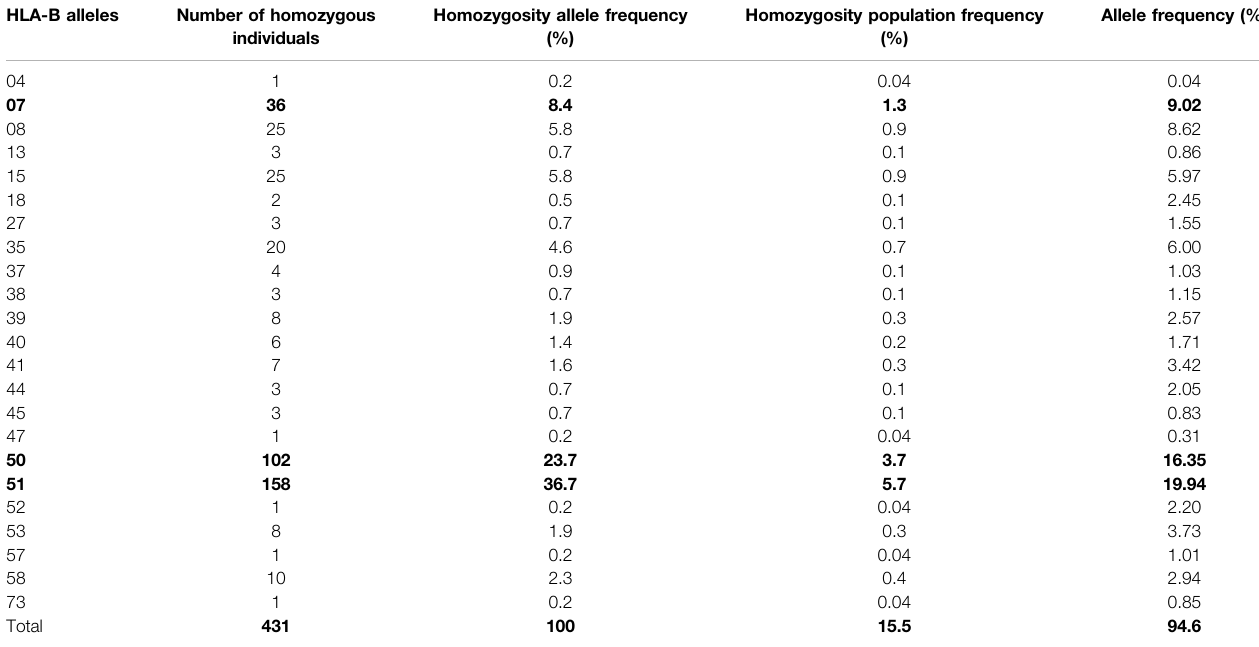
TABLE 2 | List of HLA-B alleles detected in locus B and the frequency of homozygosity and allele frequencies. HLA-B alleles Number of homozygous